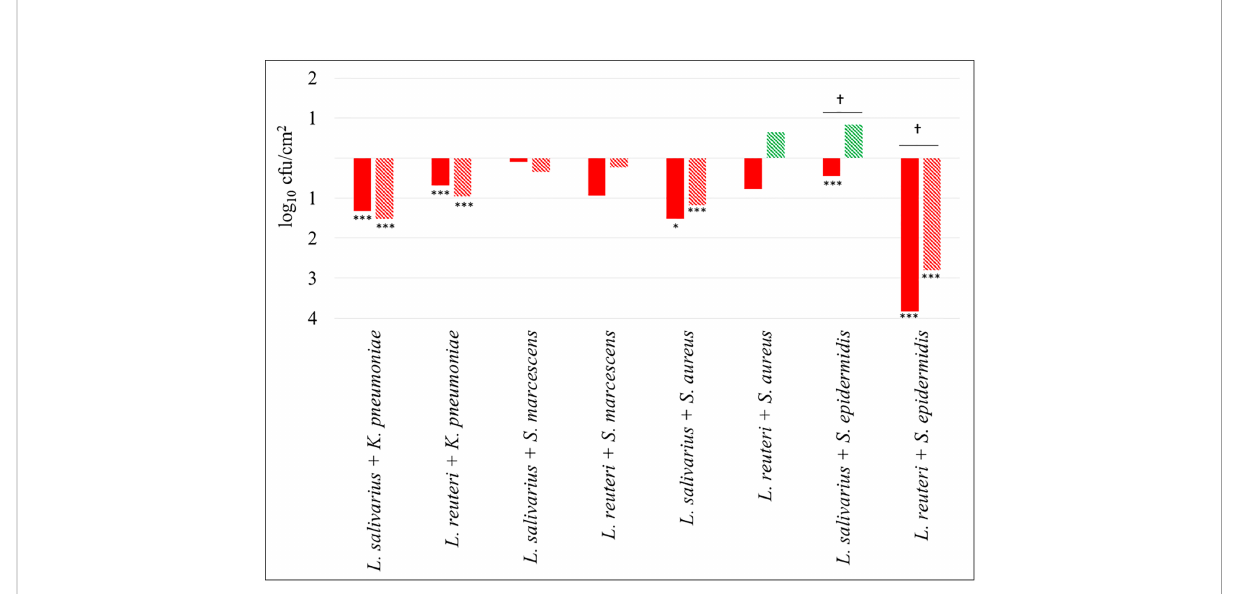
FIGURE 3 Changes in viable attached cell population (log 10 cfu/cm 2 ) in dual-species bio fi lms. Red and green bars mean log reduction or increase compared with monospecies bio fi lms of the respective pathogenic strains. Filled and lined bars represent 24 h and 48 h samples, respectively. Asterisks show statistical differences between monospecies pathogenic bio fi lms and dual-species bio fi lms with one of the LAB strains: * (p < 0.05) and *** (p < 0.001). † indicates statistical differences between 24 h and 48 h samples